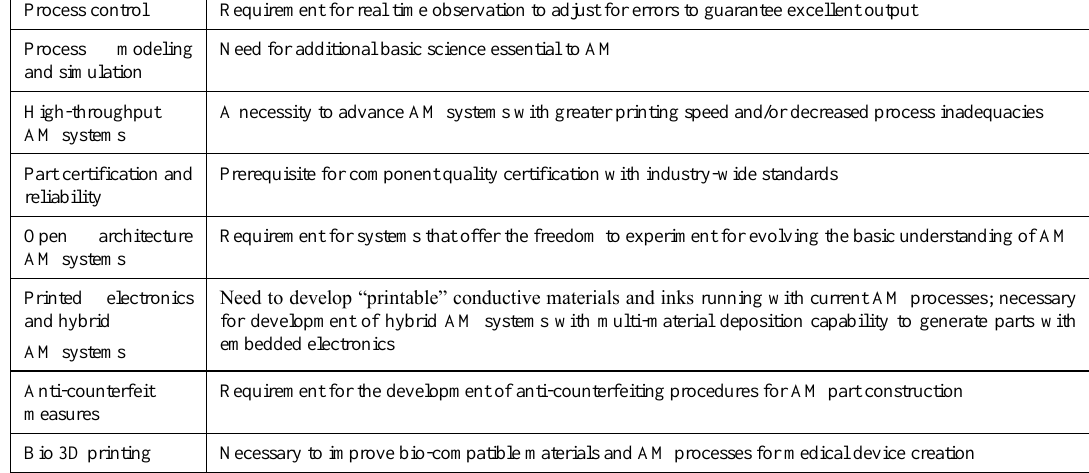
Table 7. AM research